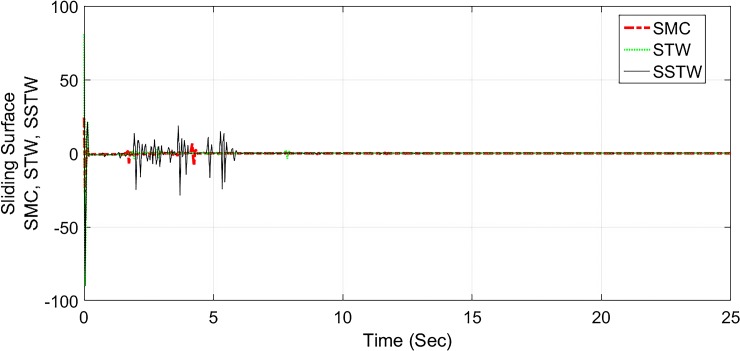
Sliding manifold convergence profile of SMC, STW and SSTW, rd = 22cm.